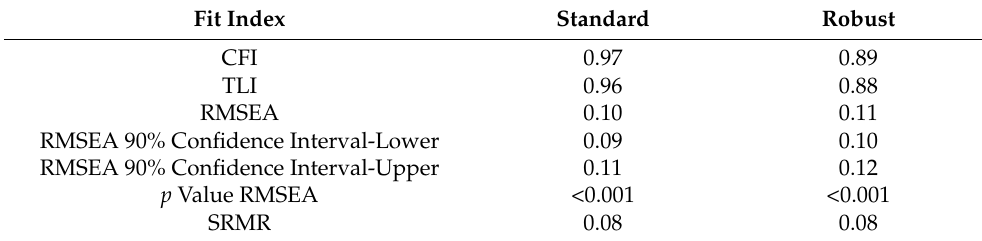
Table 2. Fit indices of User Model (Standard) versus Baseline (Standard) Model.